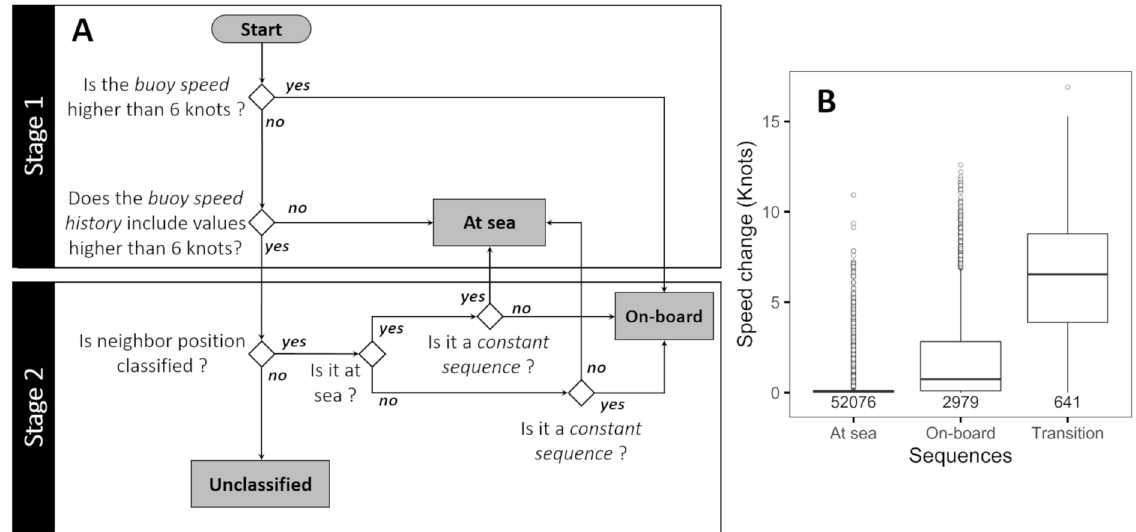
Fig. 4. Description of the kinetic classi fi cation algorithm (KiC). (A) KiC fl owchart: buoy speed history corresponds to speeds recorded 3 days prior to the buoy position. (B) Example illustrating speed changes in constant ( “ on-board ” – “ on-board ” , “ at sea ” – “ at sea ” ), and transition states ( “ on-board ” – “ at sea ” , “ at sea ” – “ on-board ” ) from the D1 dataset in the Atlantic Ocean. Values represent the number of data in each